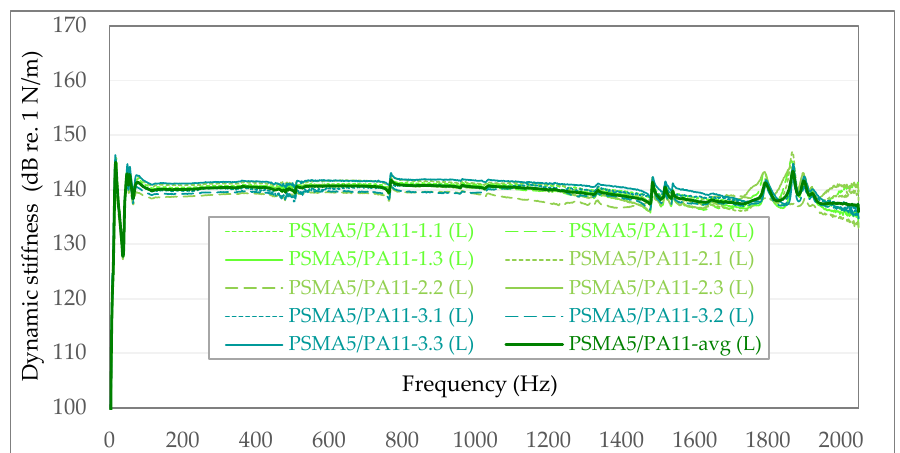
Figure 10. Dynamic stiffness in the case of the PSMA5 poroelastic layer with PA11 as binder course — laboratory measurements (L). Materials 2022 , 15 , 1821